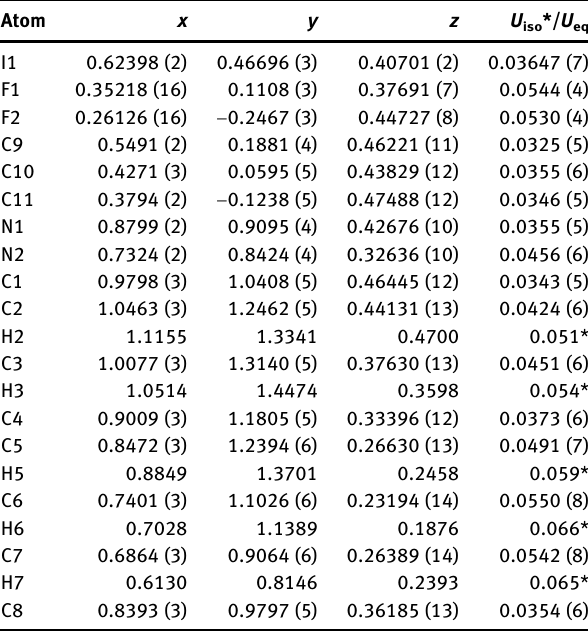
Table  : Fractional atomic coordinates and isotropic or equivalent isotropic displacement parameters (Å 